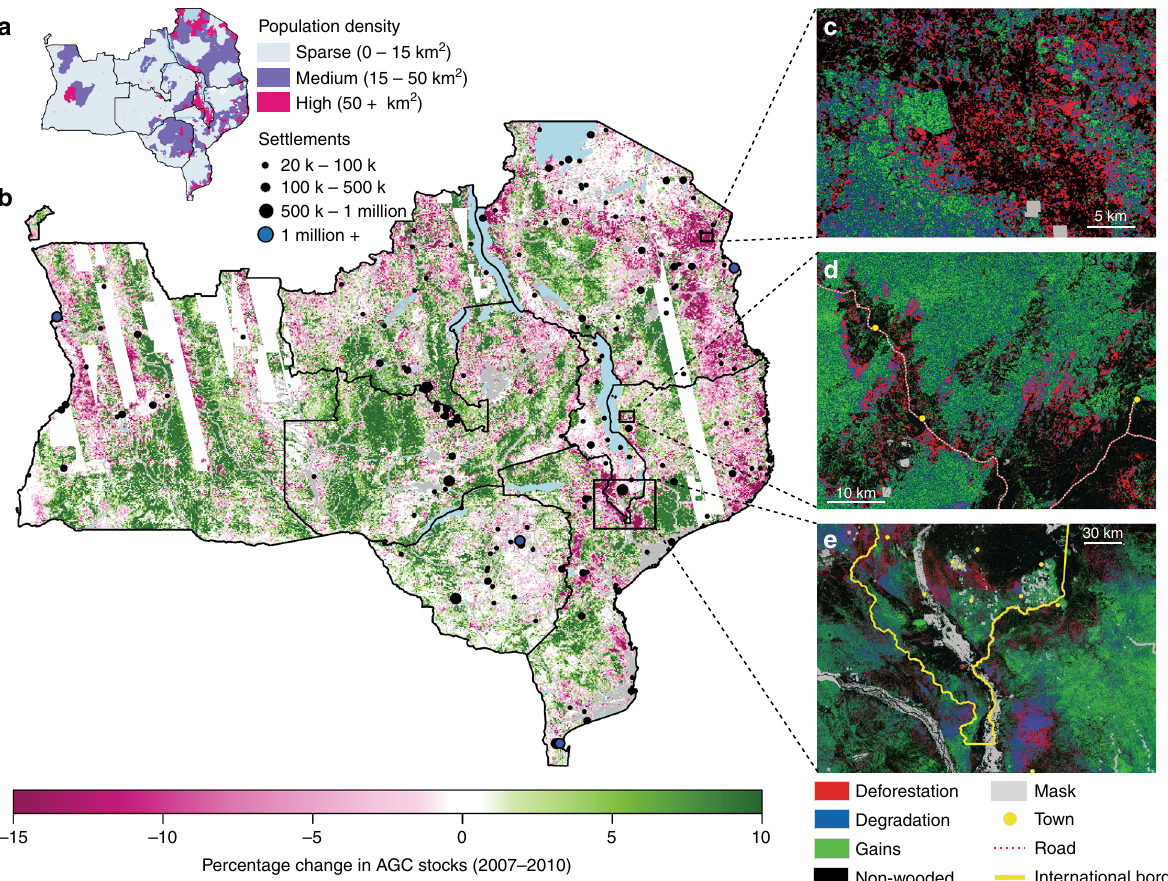
Fig. 3 Change in above ground carbon stocks between 2007 and 2010. a The human population density and centres across the study region 58 . b The mean percentage change in aboveground woody carbon stocks (AGC) at 1 km resolution. Areas masked from the study due to soil moisture differences between years are masked by the white stripes, whilst irrigation or urban land covers are masked in grey. The sub fi gures c – e are at 25 m resolution and illustrate three important syndromes of land cover change: c the deforestation (red) of small areas of woodland in an already largely deforested area of Tanzania (mopping up), d the progression of the agricultural frontier and associated deforestation and degradation (blue) to the north of Lichinga city in Mozambique, and e the extensive degradation in frontier regions of Mozambique near to the demand centres of southern Malawi, suggestive of